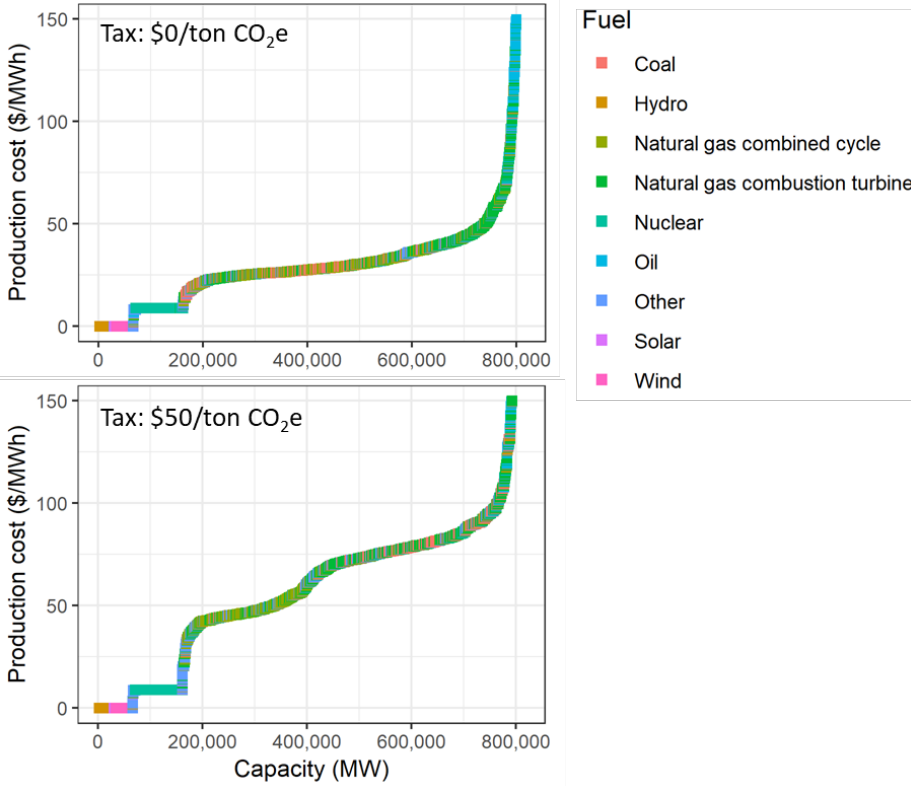
Figure 2. Short run U.S. electricity supply curve estimates with and without a carbon tax.